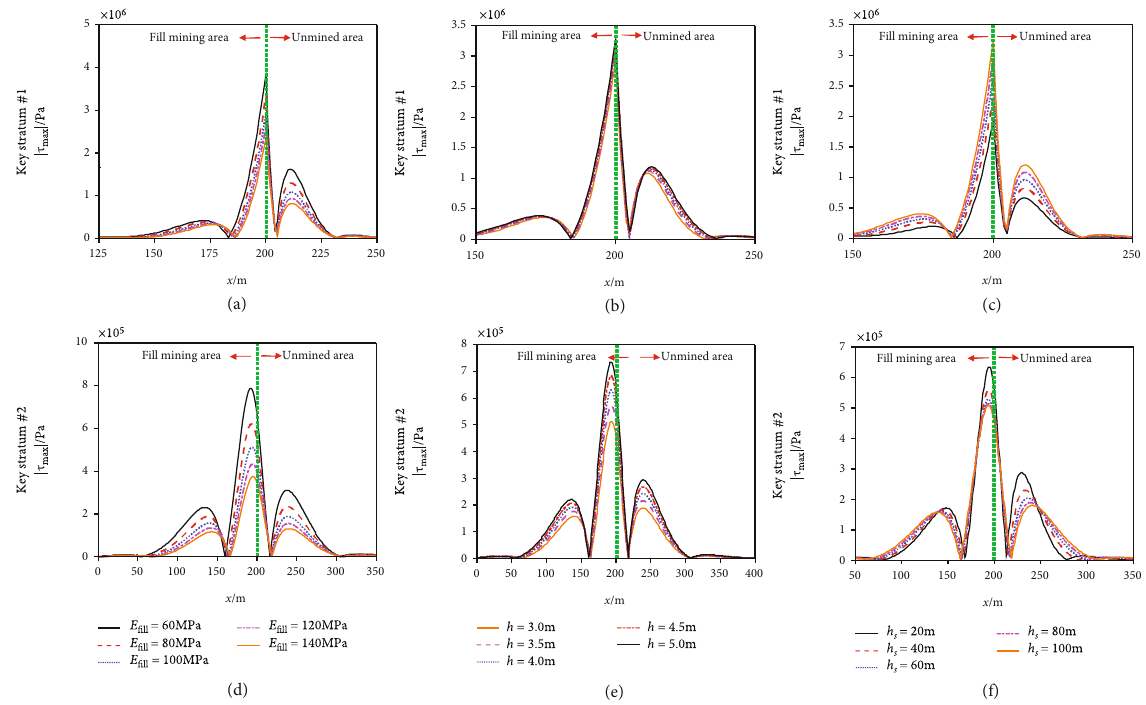
Figure 9: The shear stress distribution of key strata with the distance to the middle of the stope under various (a, d) elastic modulus of back fi ll, (b, e) mining height, and (c, f) thickness of soft